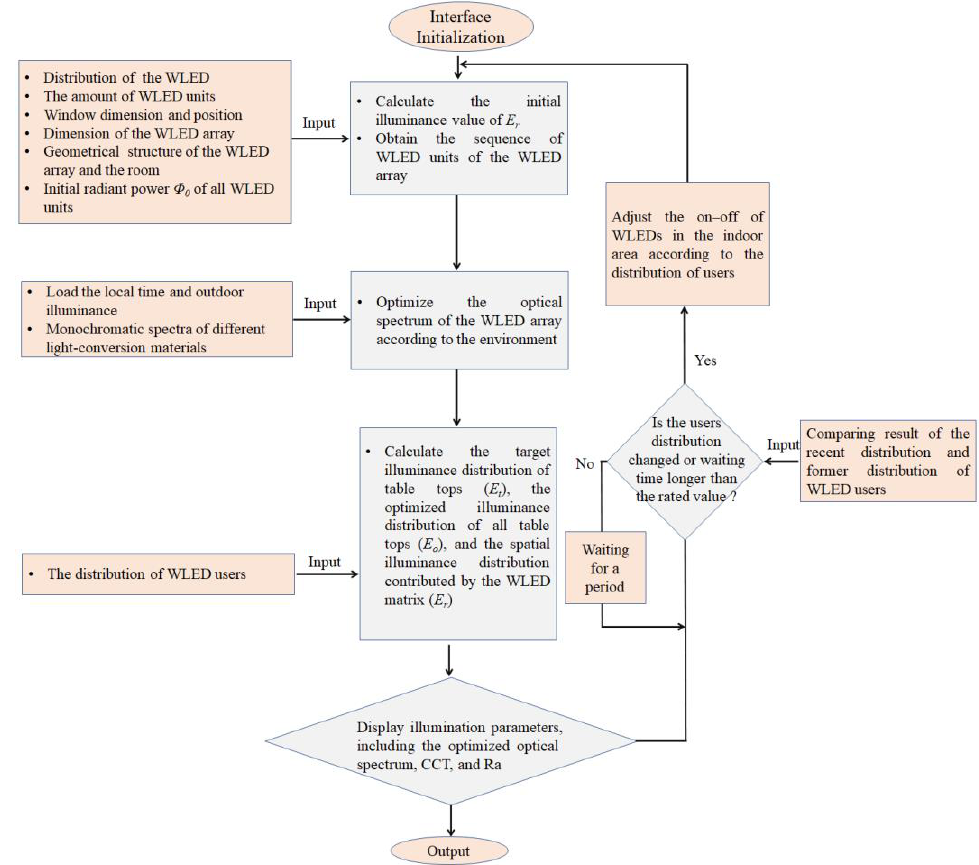
Figure 4. Flow diagram of the automatic illumination control program for the indoor WLED matrix.